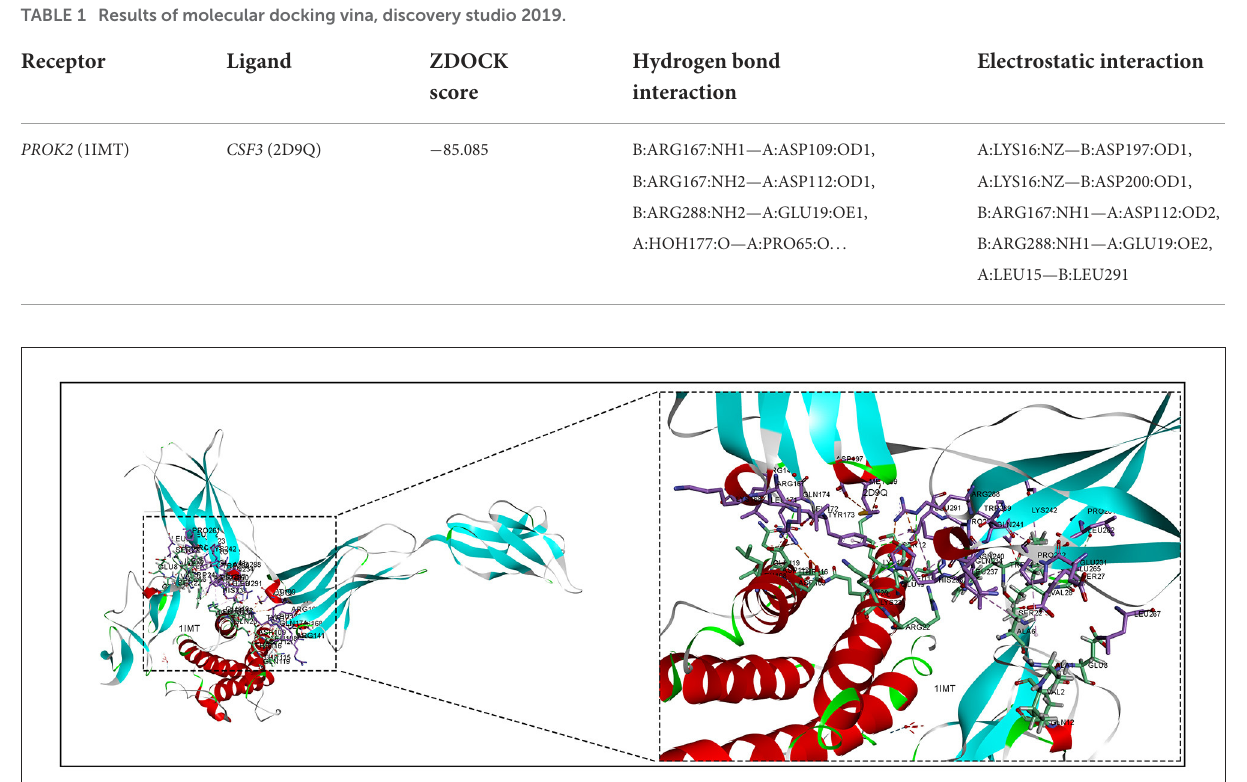
FIGURE9 Molecular docking of inflammatory proteins and protein docking